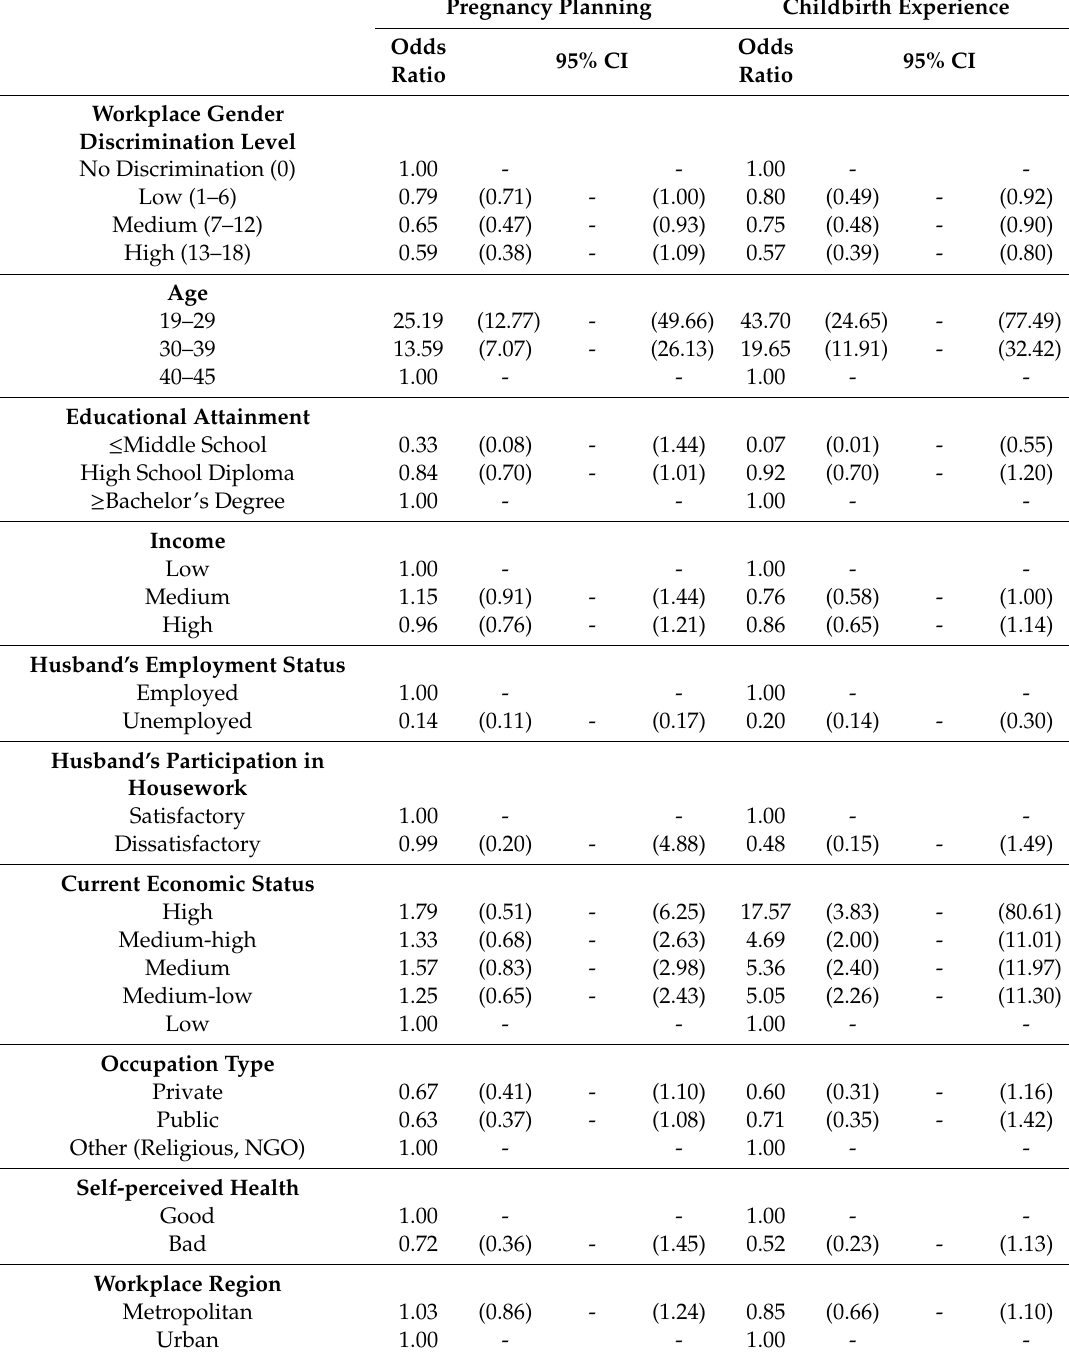
Table 3. Factors Associated with Pregnancy Planning & Childbirth Experience. Pregnancy